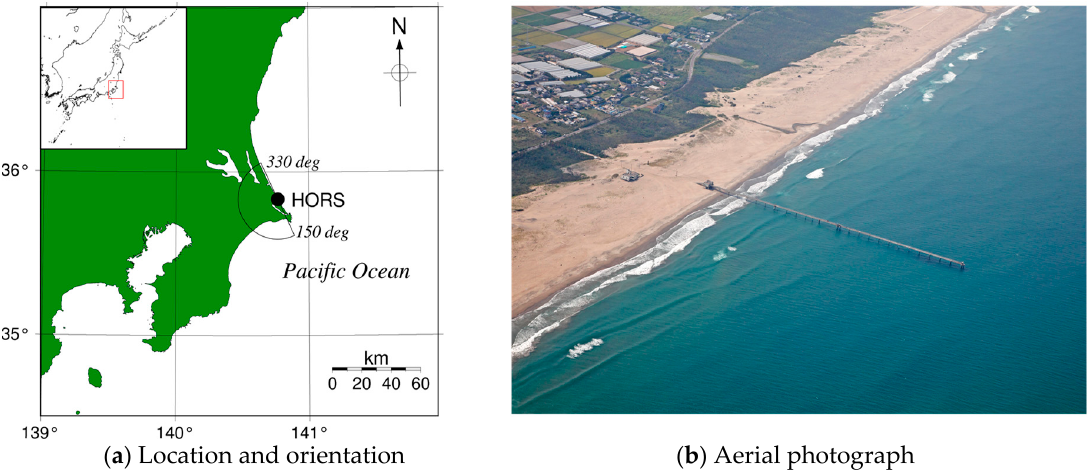
Figure 1. ( a ) Location and orientation and ( b ) aerial photograph of the Hazaki Oceanographic Research Station (HORS) research platform.